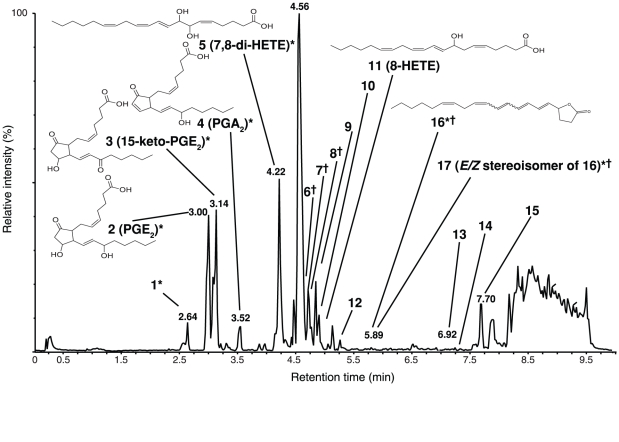
LC/MS chromatogram of mechanically wounded Gracilaria vermiculophylla.* Indicates de novo biosynthesis after labelled arachidonic acid administration with incorporation rates of 43.2–62.4 %. † Indicates co-eluting peaks.